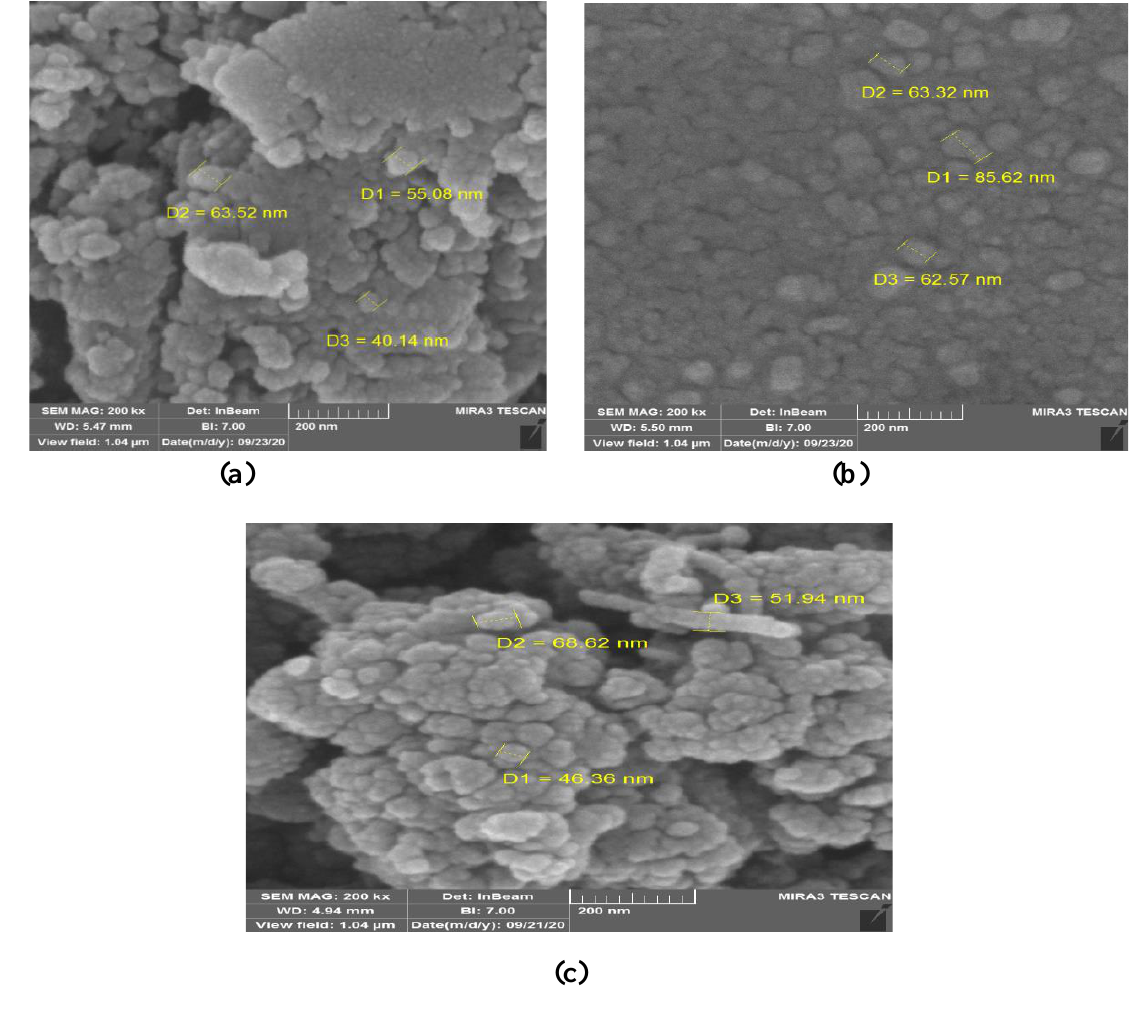
Figure 5: SEM images for porous quaternary n-Al (111) substrates at different etching times: a) 5min, b) 10 min, and c) 15